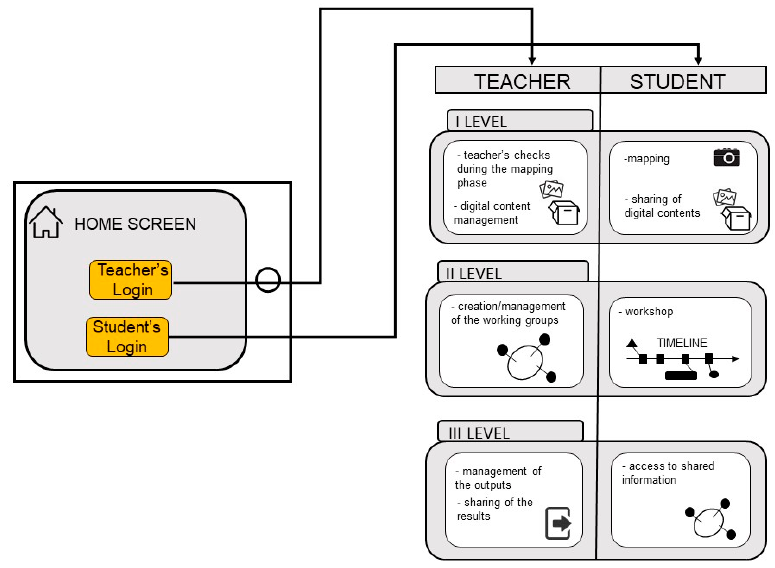
Figure 4. The app functional